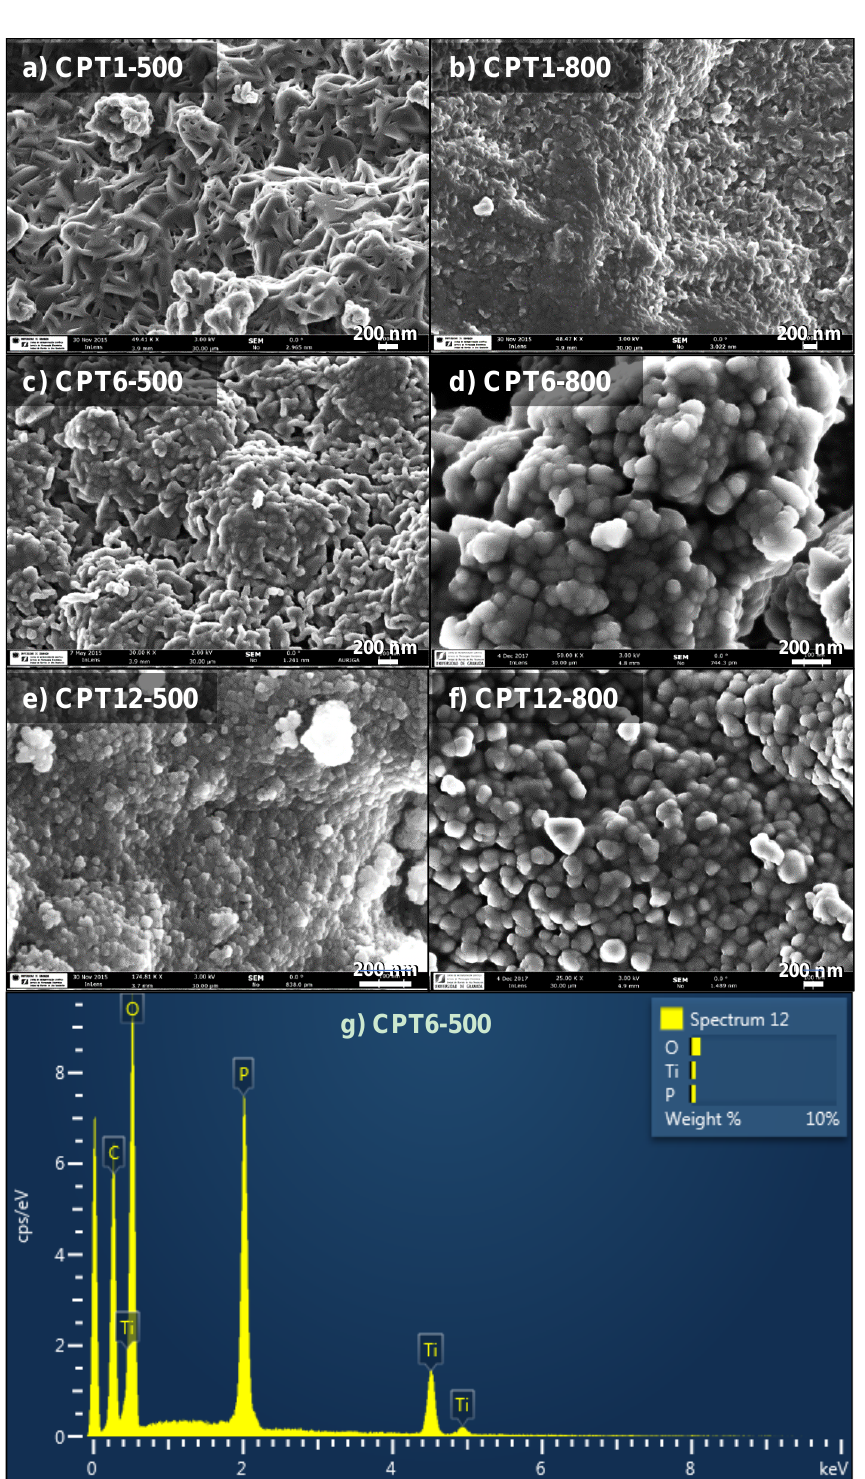
Figure 1. SEM micrographs for the carbon-phosphorus-Ti composites treated at 500 ◦ C ( a , c , e ) and 800 ◦ C ( b , d , f ), as well ( g ) EDX spectrum for the CPT6-500